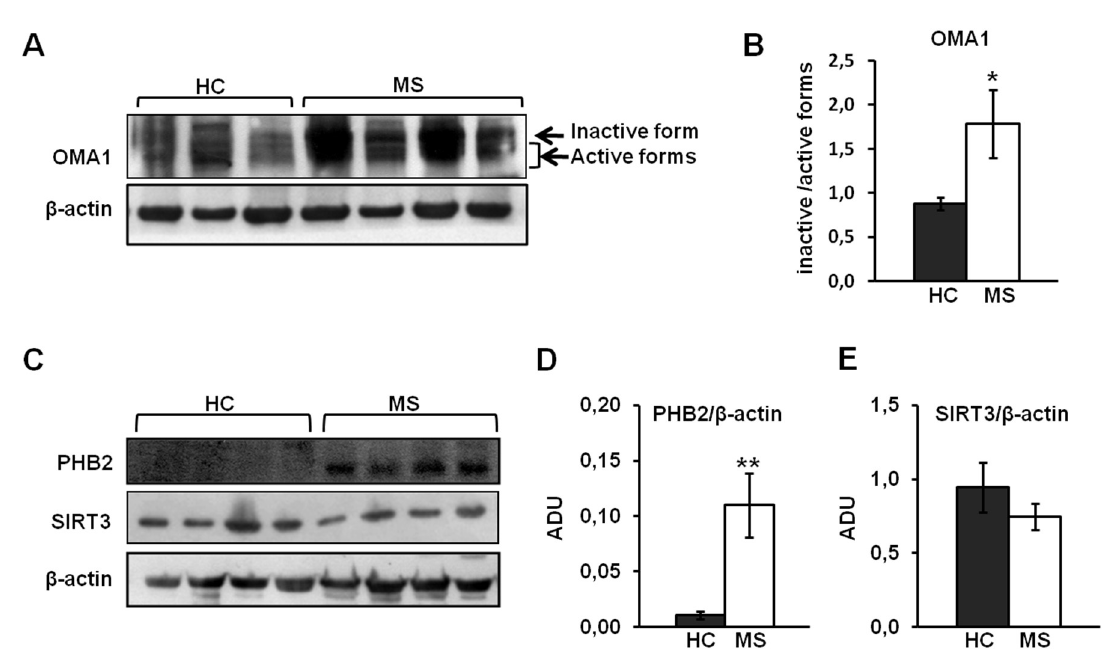
Figure 3. OMA1, SIRT3, and PHB2 in PBMCs of HC and MS patients. ( A , C ) Representative images of Western blotting analysis. Proteins from PBMC from HC and MS were loaded on 7.5% SDS-PAGE. After separation, the proteins were transferred on nitrocellulose membranes and immunoblotted with the antibodies against OMA1, SIRT3, and PHB2. Protein loading was assessed with β -actin antibody. The immunoblotting against β -actin in panel C is the same shown in the Figure 1A, belonging to the same experiment series ( B , D ). ( B ) The histograms represent the means of ratio values ± SEM between the ADU of inactive and active forms of OMA1 in HC and MS subjects. ( D , E ) The ADU of PHB2 and SIRT3 were normalized to ADU of β -actin. The histograms represent the means of values of ADU ± SEM of samples. (* p < 0.05, ** p < 0.01; Student’s t -test).